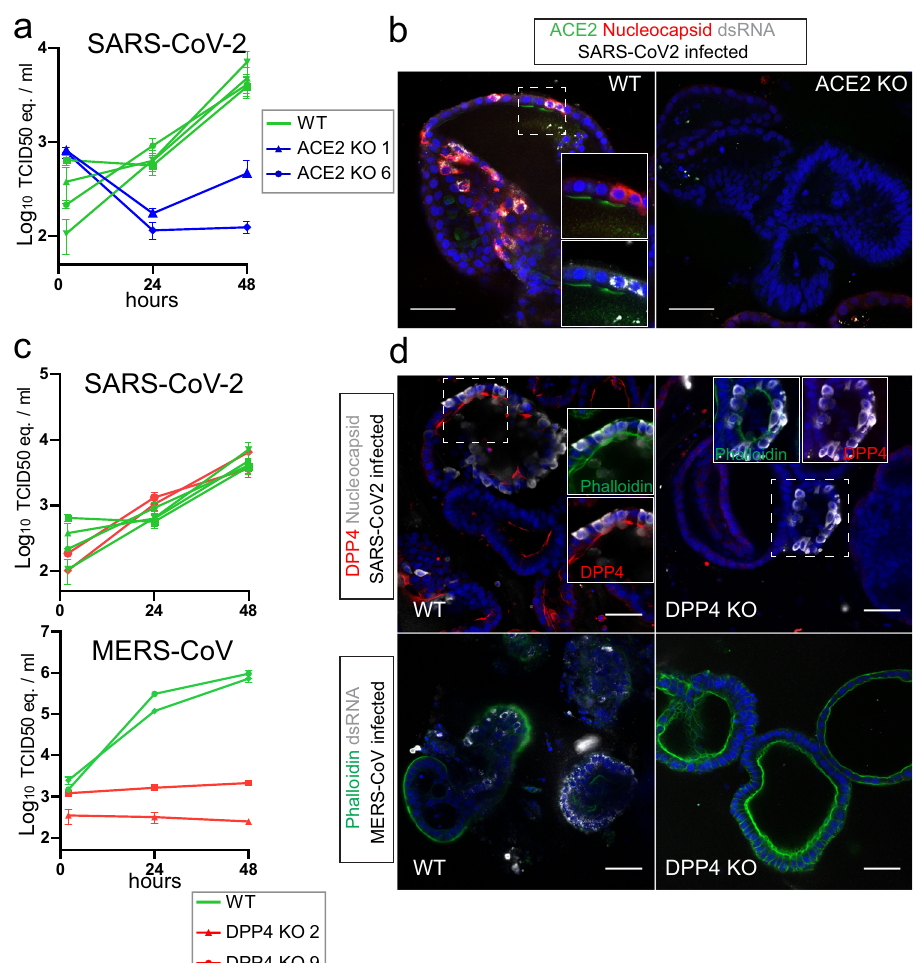
Fig. 3 ACE2 and DPP4 are the obligate entry receptors for SARS-CoV-2 and MERS-CoV, respectively. a qPCR analysis targeting the E gene to quantify viral replication of wildtype (WT) and ACE2 knockout (KO) organoids. Error bars represent SEM. Each data point represents the mean of 3 replicates. b Immuno fl uorescent staining of WT and ACE2 KO organoids, infected with SARS-CoV-2 visualized by nucleocapsid protein and dsRNA. ACE2 locates to the apical membrane and is absent in mutant organoids. Scale bars are 50 µ m. Experiment was repeated 3 times with similar results. c qPCR analysis targeting the E gene (SARS-CoV-2) or upE region (MERS-CoV) to quantify viral replication in WT and DPP4 KO organoids. Error bars represent SEM. Each data point represents the mean of 3 replicates. d Immuno fl uorescent staining of MERS-CoV (visualized by dsRNA) and SARS-CoV-2 (visualized by nucleocapsid protein) infected organoids. DPP4 locates to the apical membrane and is absent in mutant organoids. Scale bars are 50 µ m. Experiment was repeated 2 times with similar